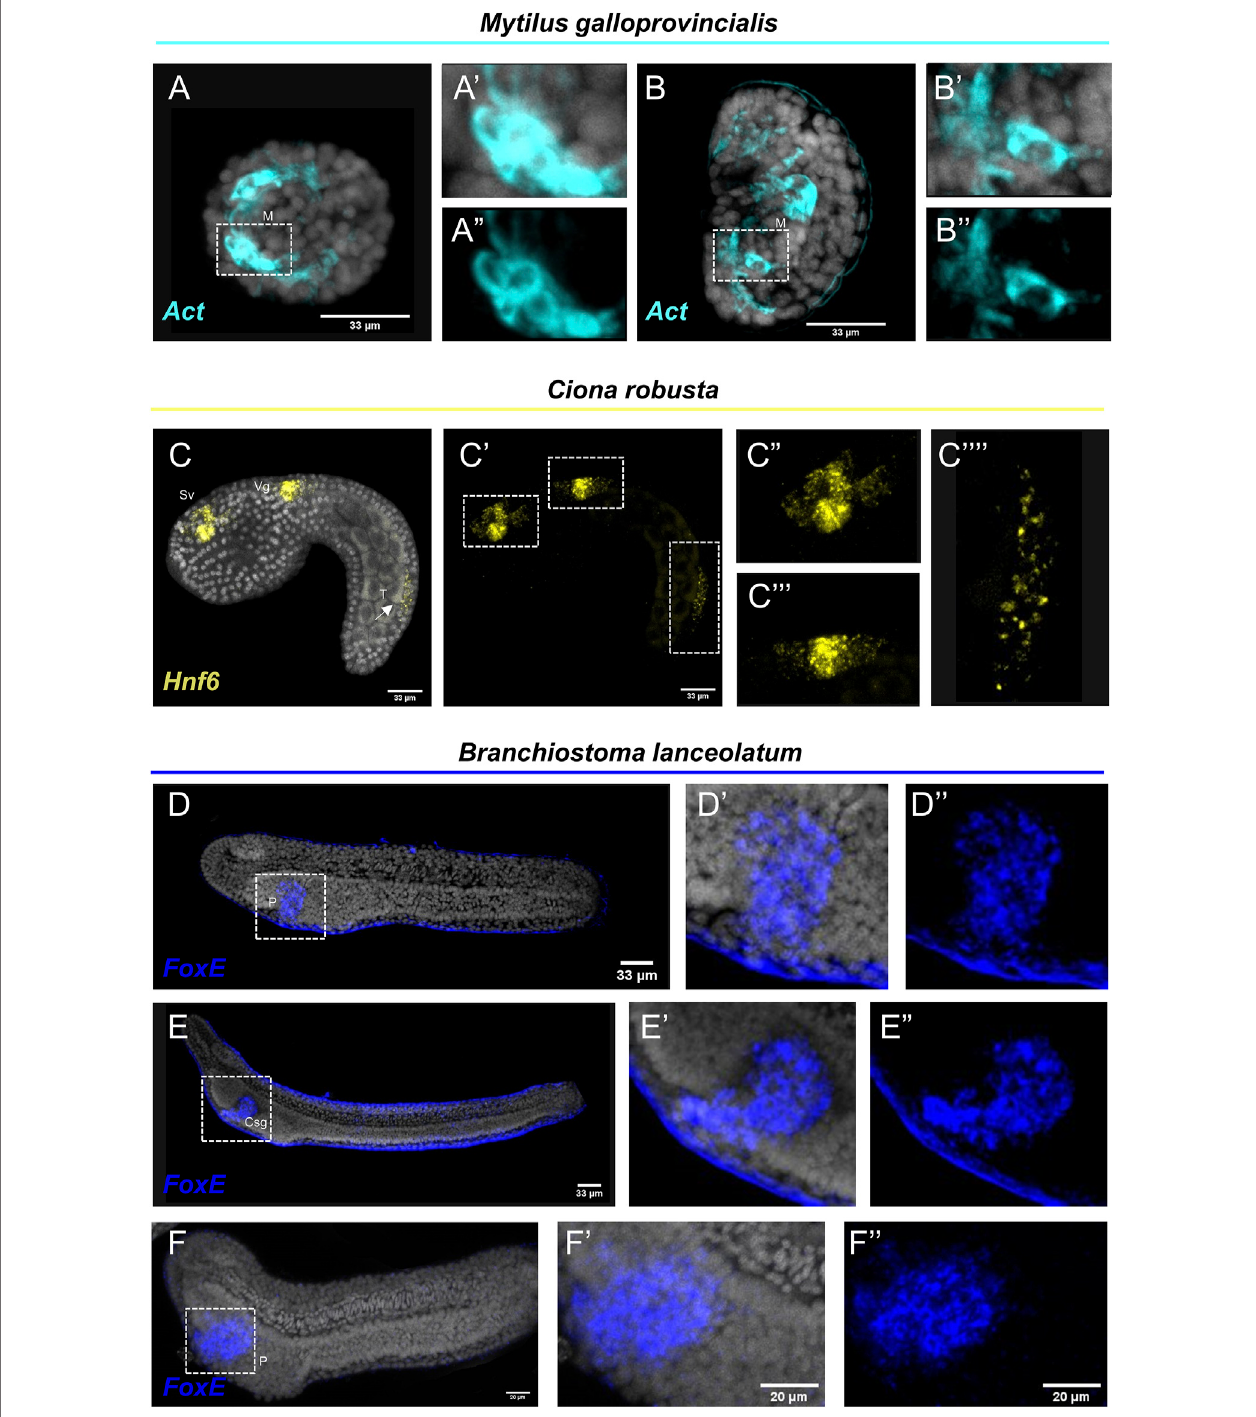
FIGURE 3 | Expression patterns of known gene markers in mollusk, tunicate and cephalochodate representatives through FISH. FISH of M. galloprovincialis embryos (A – A ’’ ) and larvae (B – B ’’ ) with antisense probe for Actin ; C. robusta embryo with antisense probe for Hnf6 (C – C ’’ ) ; B. lanceolatum embryo (D – D ’’ ) and larva (E – E ’’ ) nottreatedandtreatedwithProteinaseK (F – F ’’ ) withantisenseprobefor FoxE .NucleiarelabelledwithDAPI(ingrey).AllimagesarestacksofmergedconfocalZ sections. Csg, club-shaped gland; M, Muscle; P, Pharyngeal endoderm; Vg, Visceral ganglion; Sv, Sensory vesicle; T, Tail. Arrow indicates positive cells in the posterior neural